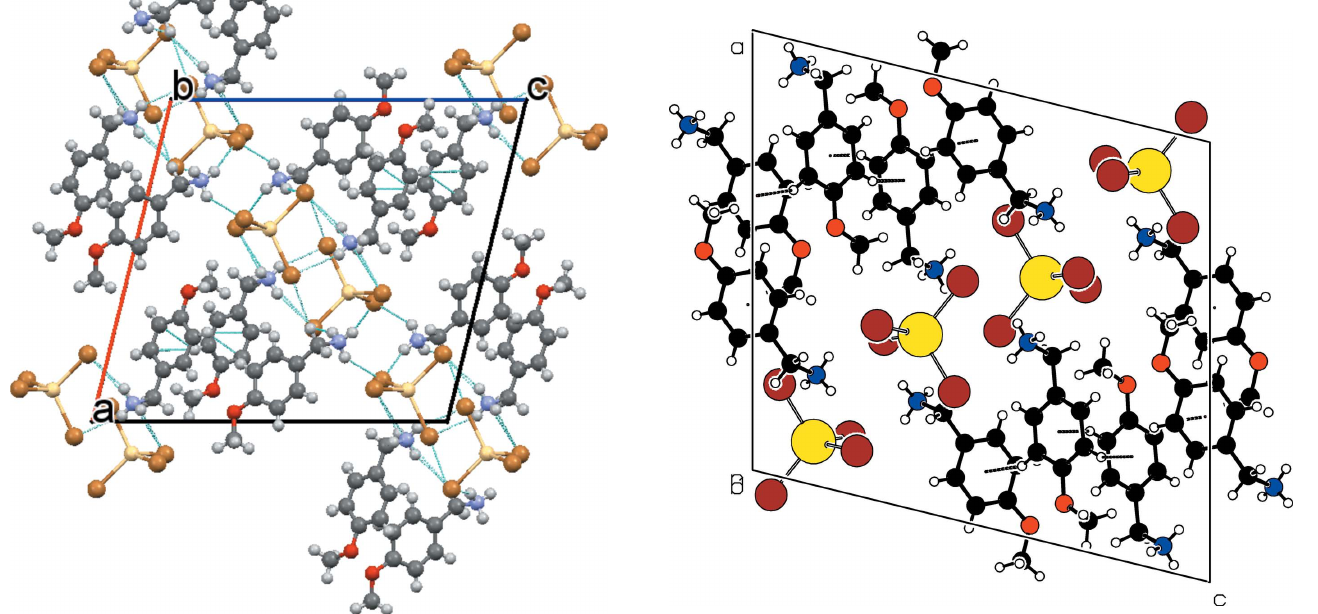
Figure 3 A partial packing diagram showing the C—H (cid:3)(cid:3)(cid:3) (cid:2) interactions (details in Table 1).